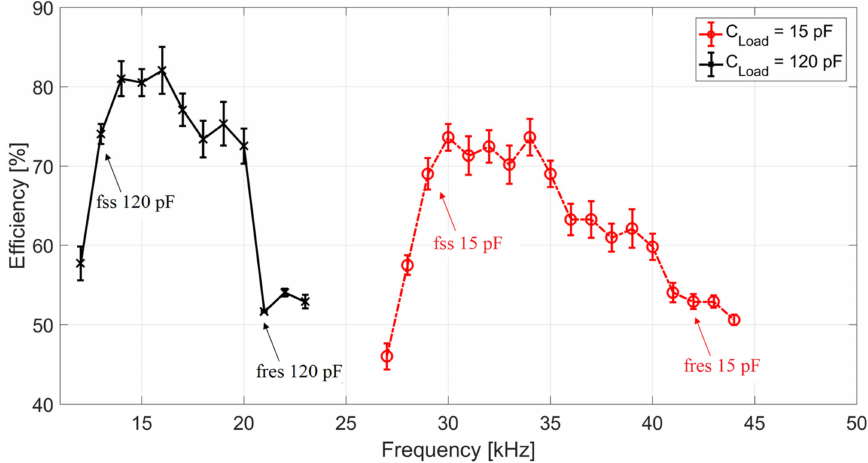
Figure 11. Generator e ffi ciency as a function of the switching